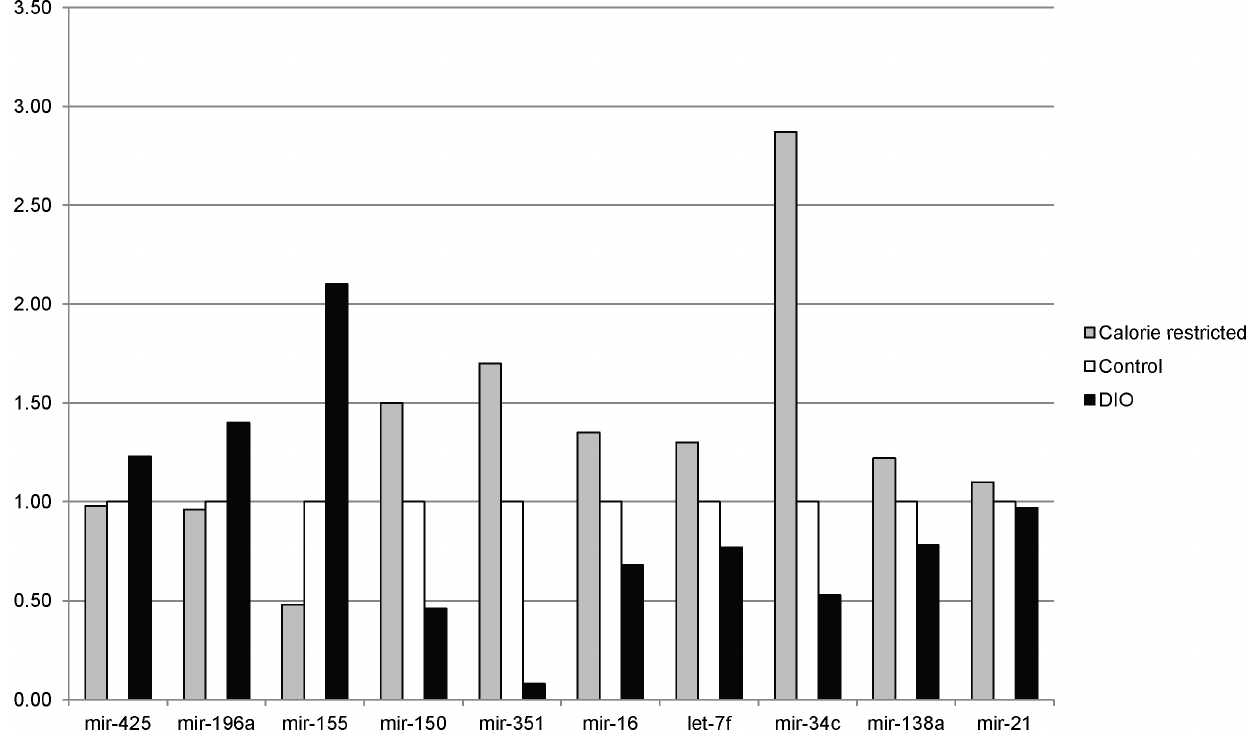
Figure 7. Real time PCR of microRNAs to validate microarray. Ten miRs were validated using real-time PCR. They included miR-425, miR-196a, miR-155, miR-150, miR-351, miR-16, let-7f, miR-34c, miR-138a, and miR-21. Results were analyzed using the comparative C T method and reported as fold differences compared to the control group. Each bar represents the mean of six animals.